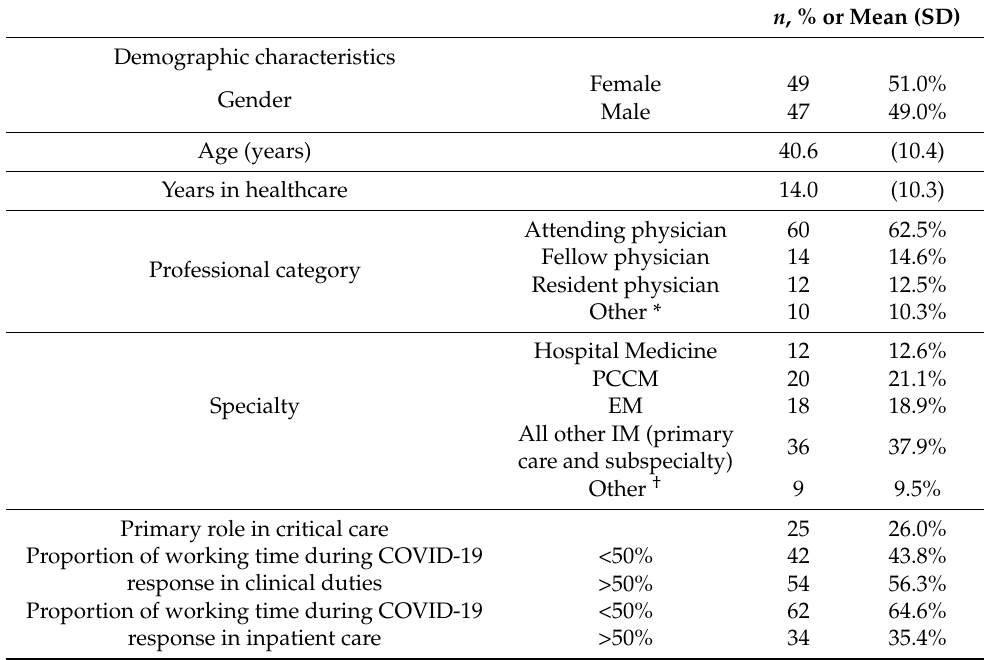
Table 1. Demographic and occupational characteristics of participants completing baseline and 3 month surveys ( n = 96).